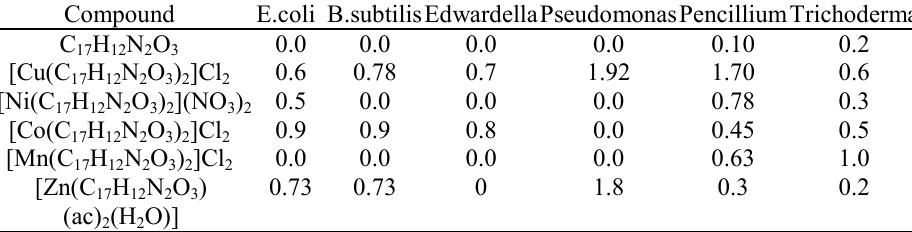
Table-5. Antibacterial activity in centimeter